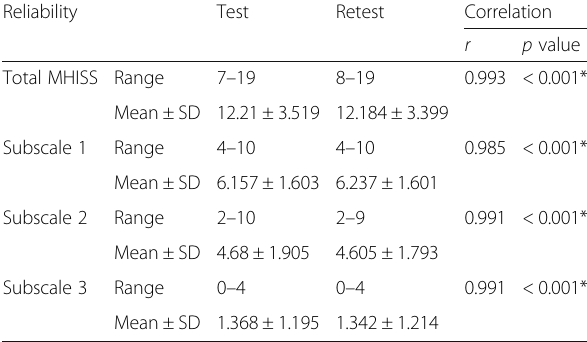
Table 3 Test – retest reliability of the Arabic version of